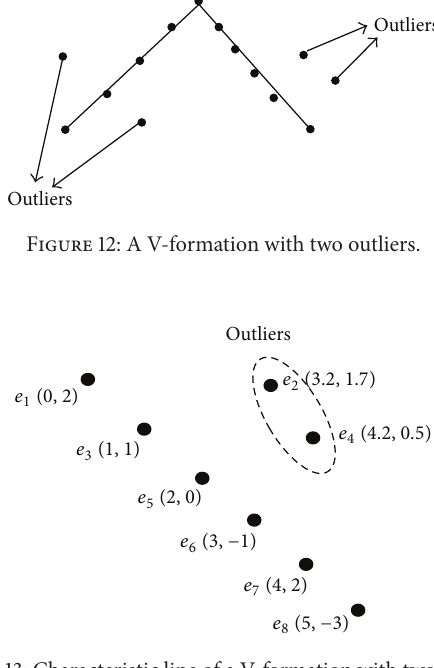
Step 5. Pearson = PearsonCoefficient ( lineMembers ) = 1.